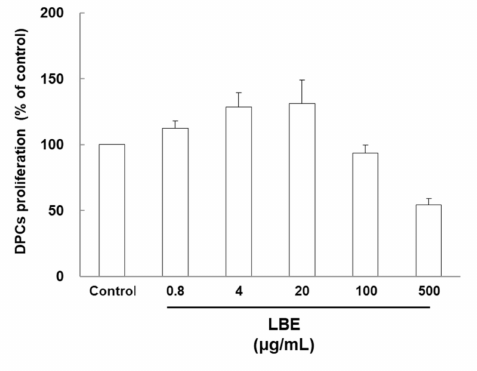
Figure 1. Cytotoxicity of Lespedeza bicolor extract (LBE) in DPCs. Cells were treated with various concentrations of LBE for 24 h. Representative data of each group are expressed as mean ± SD.